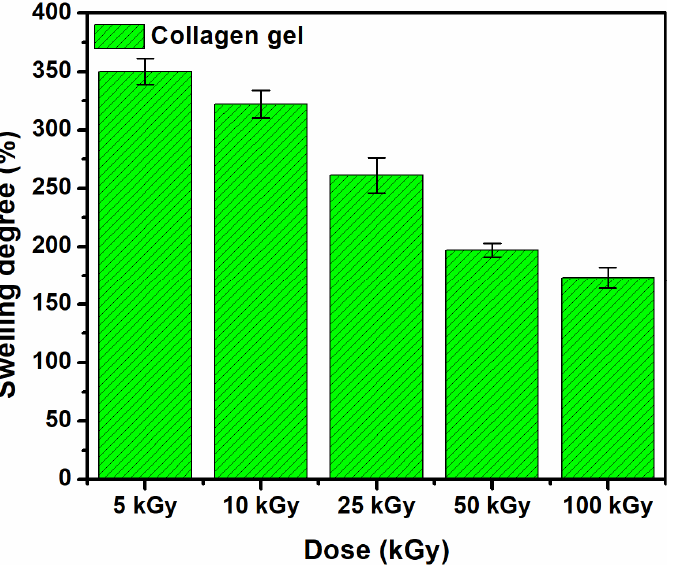
Figure 2. The swelling degree of e ‐ beam crosslinked collagen hydrogels in PBS at 37 °C for 48 h.